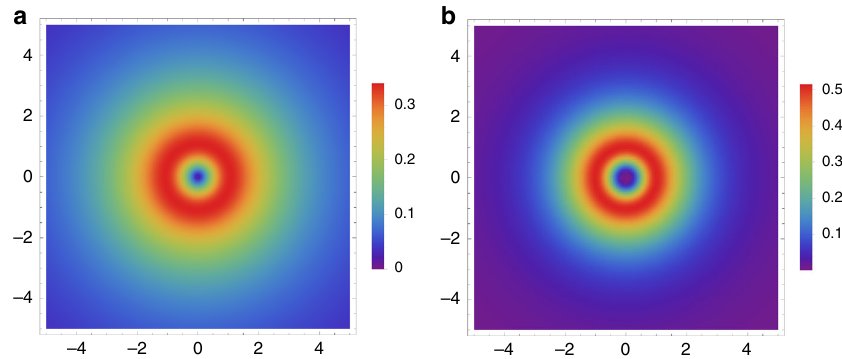
Fig. 1 Radial probability densities of bielectron vortices A plot of the radial probability densities for the fi rst two bielectron states, with the quantum numbers a ( m , n ) = (1, 0) and b ( m , n ) = (2, 0), as a function of position in two-dimensions. The spatial coordinates are measured in units of the length scale d . The color bar measures the dimensionless number associated with the probability density. The interaction strengths are given by